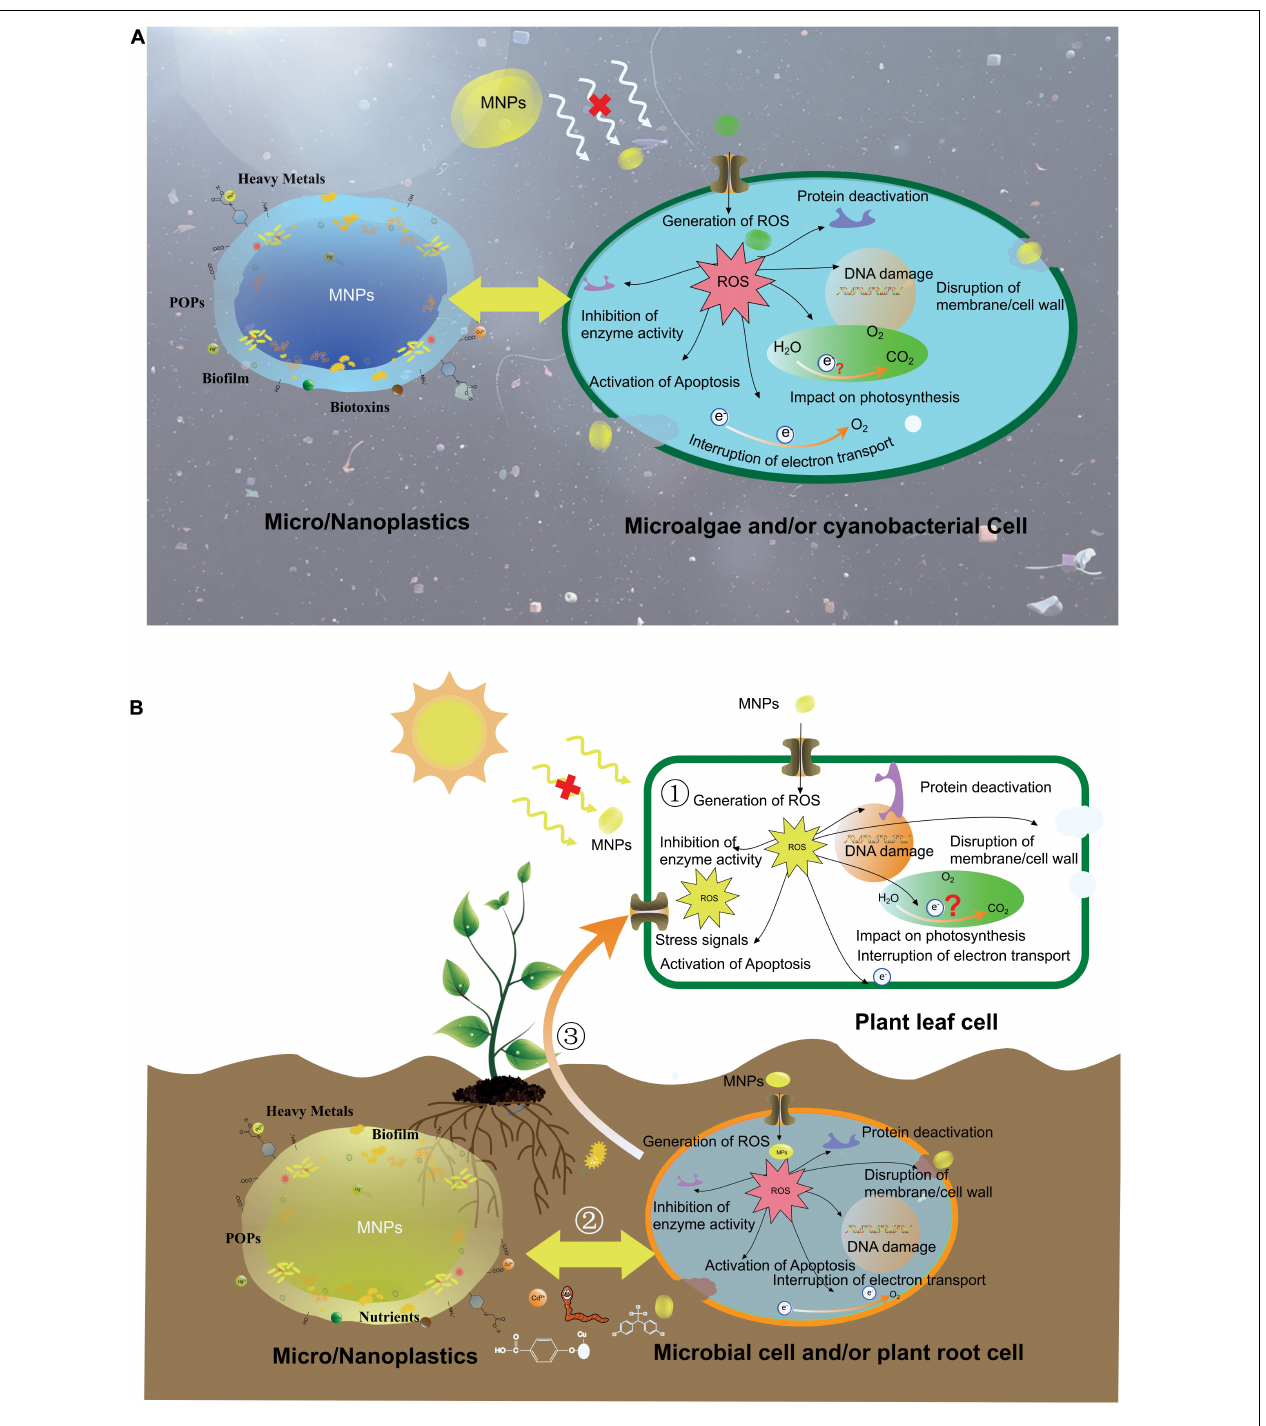
FIGURE 2 | Schematics of the potential impacts of MPs on aquatic photosynthetic organisms (A) and terrestrial photosynthetic organisms (B) .